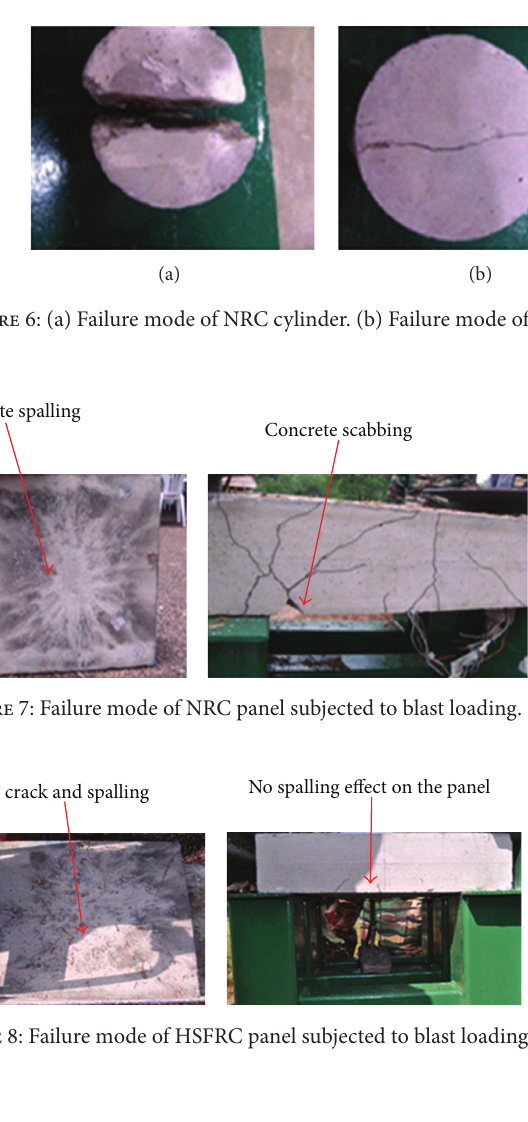
Figure 8: Failure mode of HSFRC panel subjected to blast